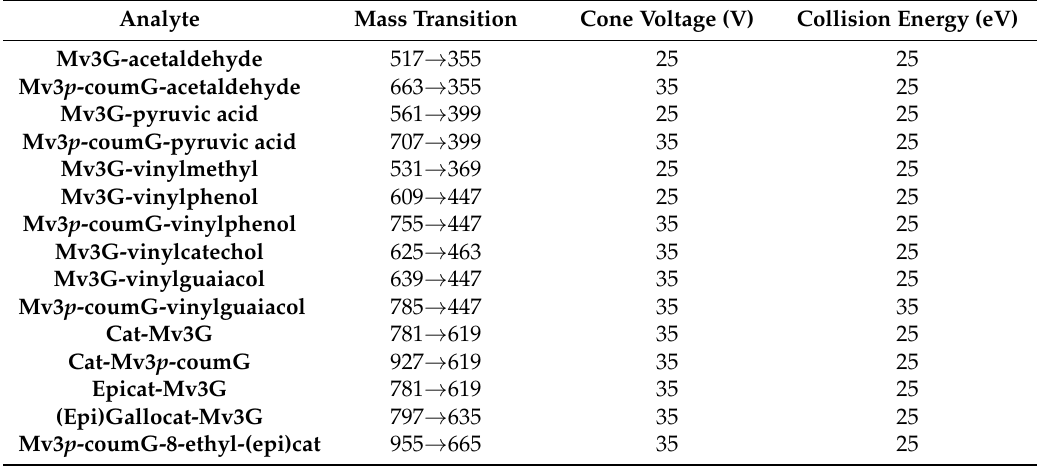
Table 5. Analysis of anthocyanin-derived pigments: parameters for multiple reaction monitoring